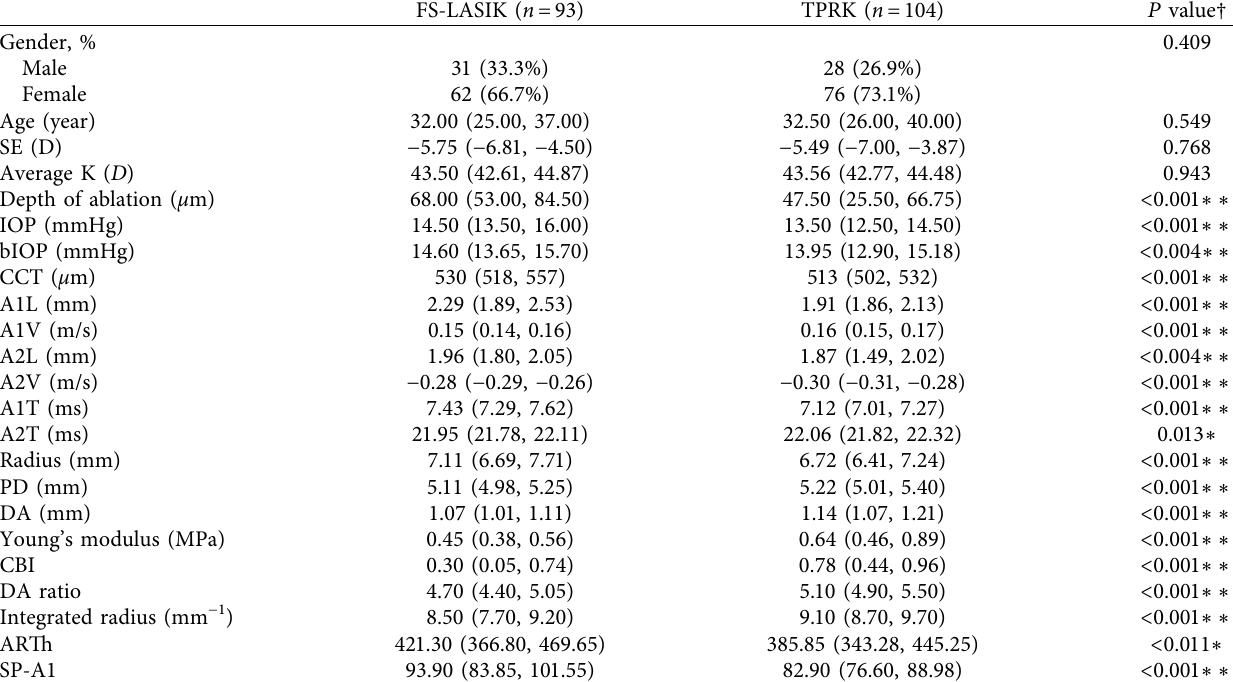
Table 1: Patients’ demographic data, refractive status, and corneal biomechanical properties.